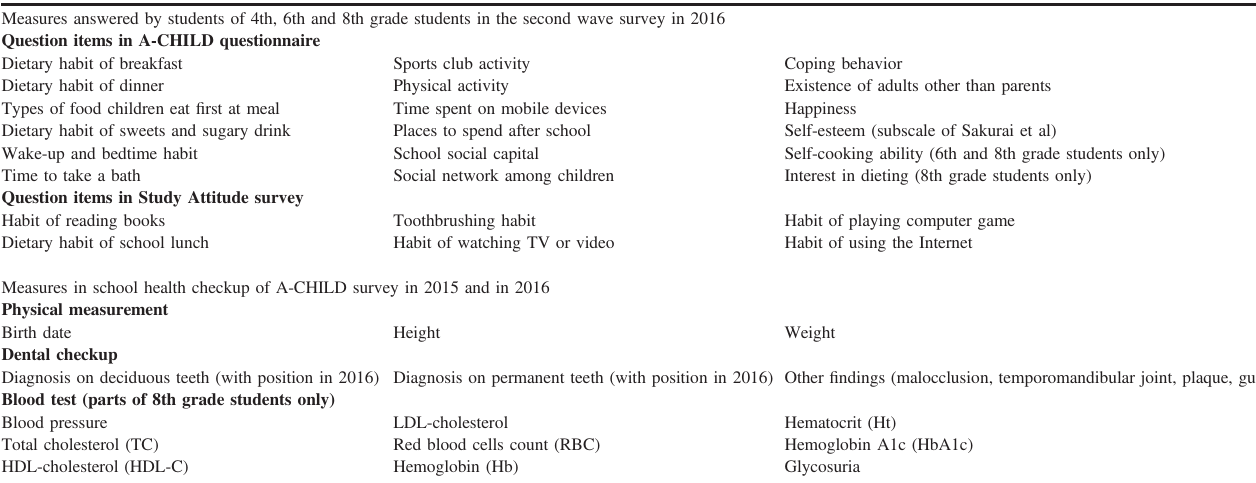
Table 2. List of measures answered by children in A-CHILD study in 2015 and 2016 Measures answered by students of 4th, 6th and 8th grade students in the second wave survey in 2016 Question items in A-CHILD questionnaire Dietary habit of